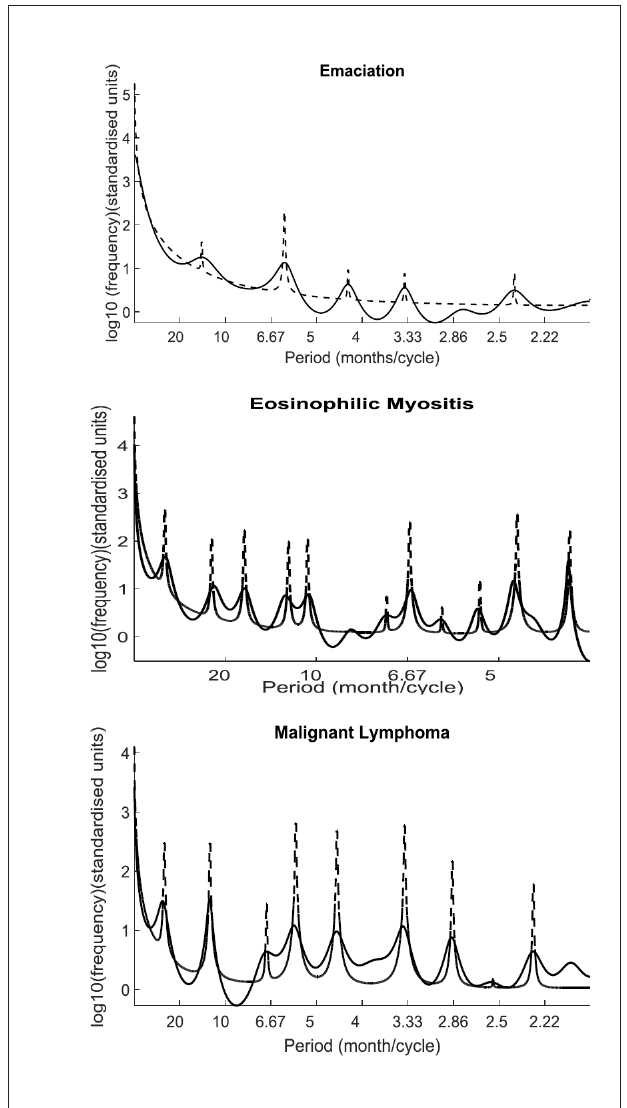
FigUre 6 | Autoregressive spectrum (23th order) of the reported emaciation (top), eosinophilic myositis (middle) and malignant lymphoma (bottom) condemnation cases in slaughterhouses in California. Solid line indicates the autoregressive spectrum of the carcass condemnation rate. The dashed line indicates the AR spectrum of the DHR model of the carcass condemnation rate using frequency domain NVR